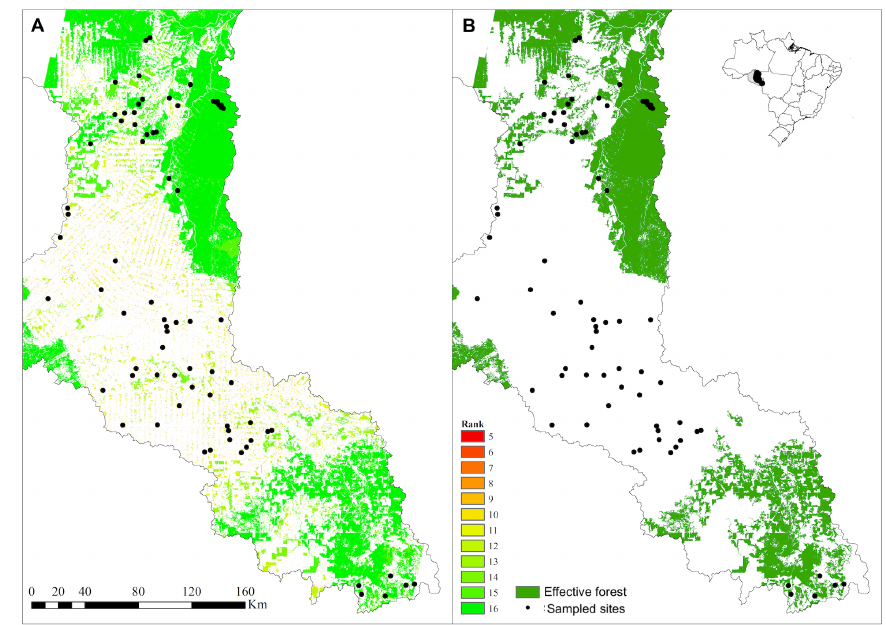
FIGURE 2 | Distribution of sampling sites with ( A ) forest patches ranked according to the forest quality multimetric index and ( B ) effective forest cover. Non-forested area is white and is not included in the multimetric index calculation (or